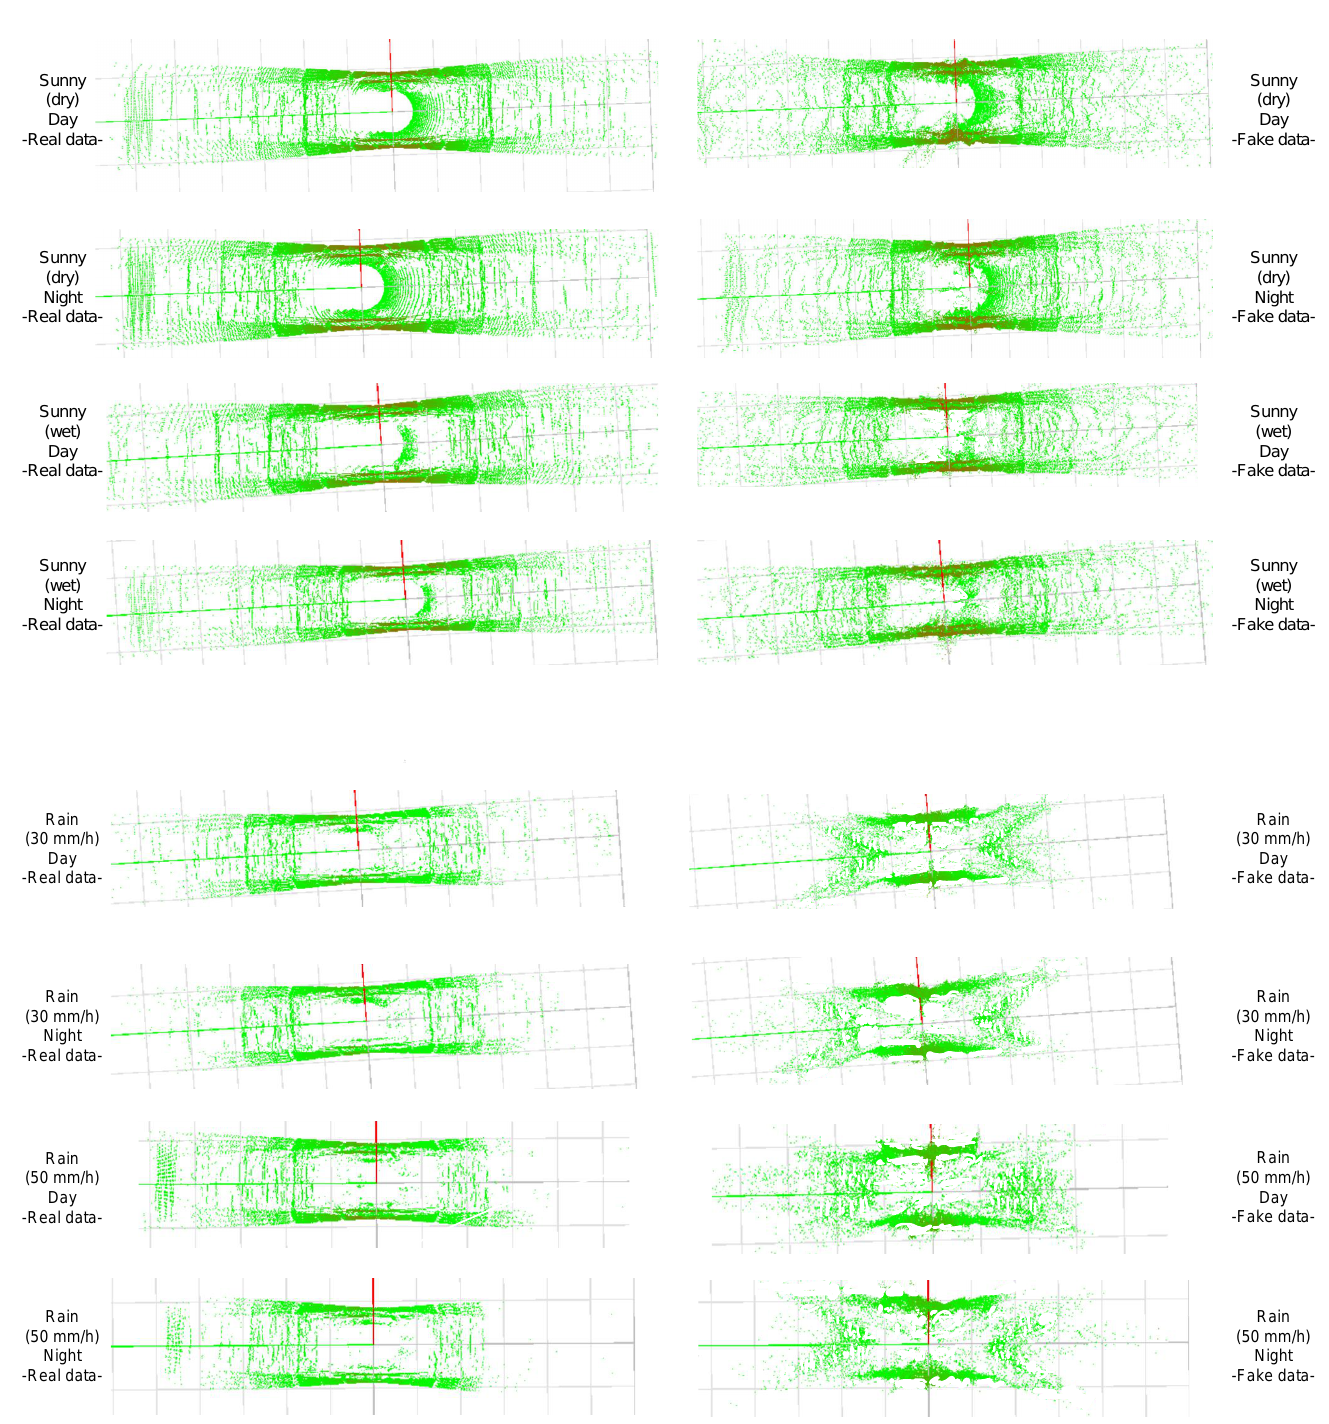
Figure 6. Examples of translation between sunny and adverse weather conditions with the JARI data set. The results are reconstructed 3D points seen from above. The green points indicate reconstructed 3D points. The red points indicate the comparatively high value of intensity. We show the translation results between sunny(wet) and rainy conditions. The images on the left are the real data for the source domains, while those on the right are the generated data for the target domains. Even though there was some noise in the generated data, the proposed method can reflect the changes according to various environmental